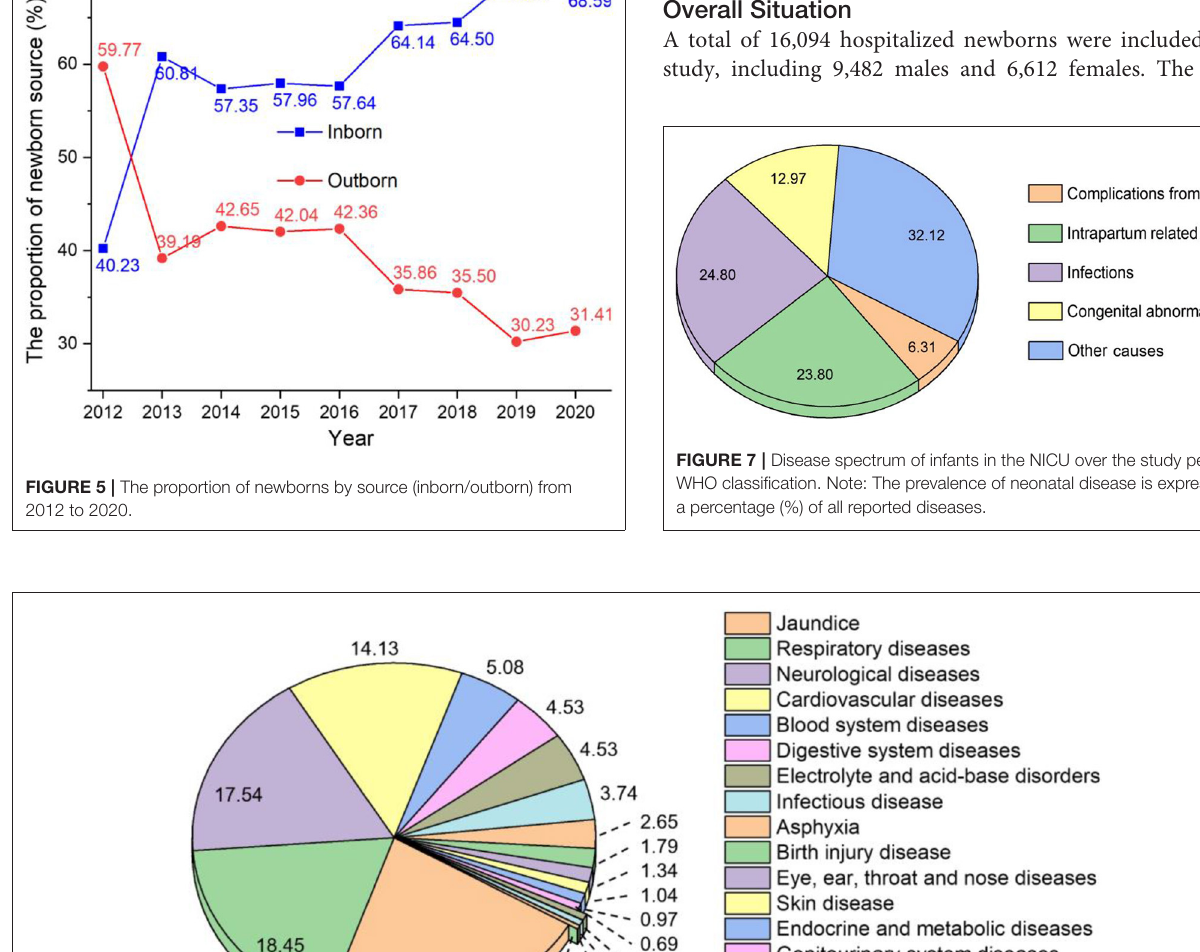
Frontiers in Pediatrics |